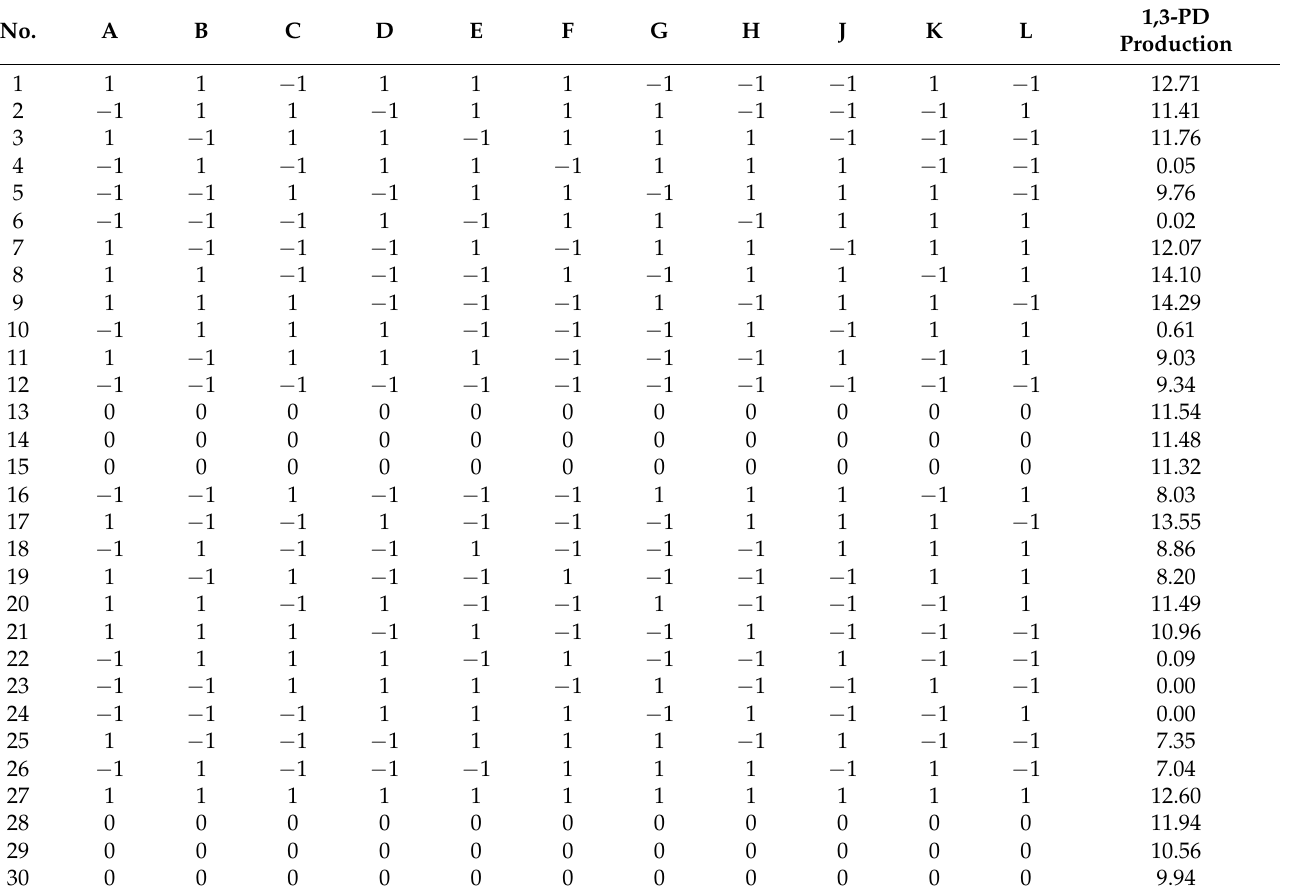
Table 2. Plackett–Burman design for 11 variables with coded values along with observed results for 1,3-PD production.